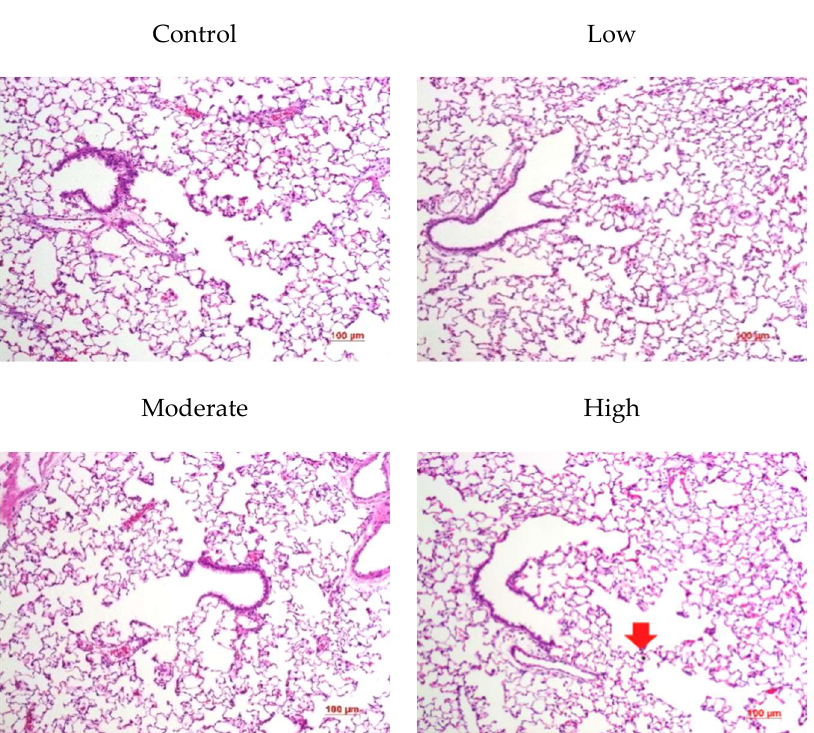
Figure 7. Lung histopathology of female rats at 1 day after CNF exposure; arrow: alveolar macrophage with ingested CNF (×100).